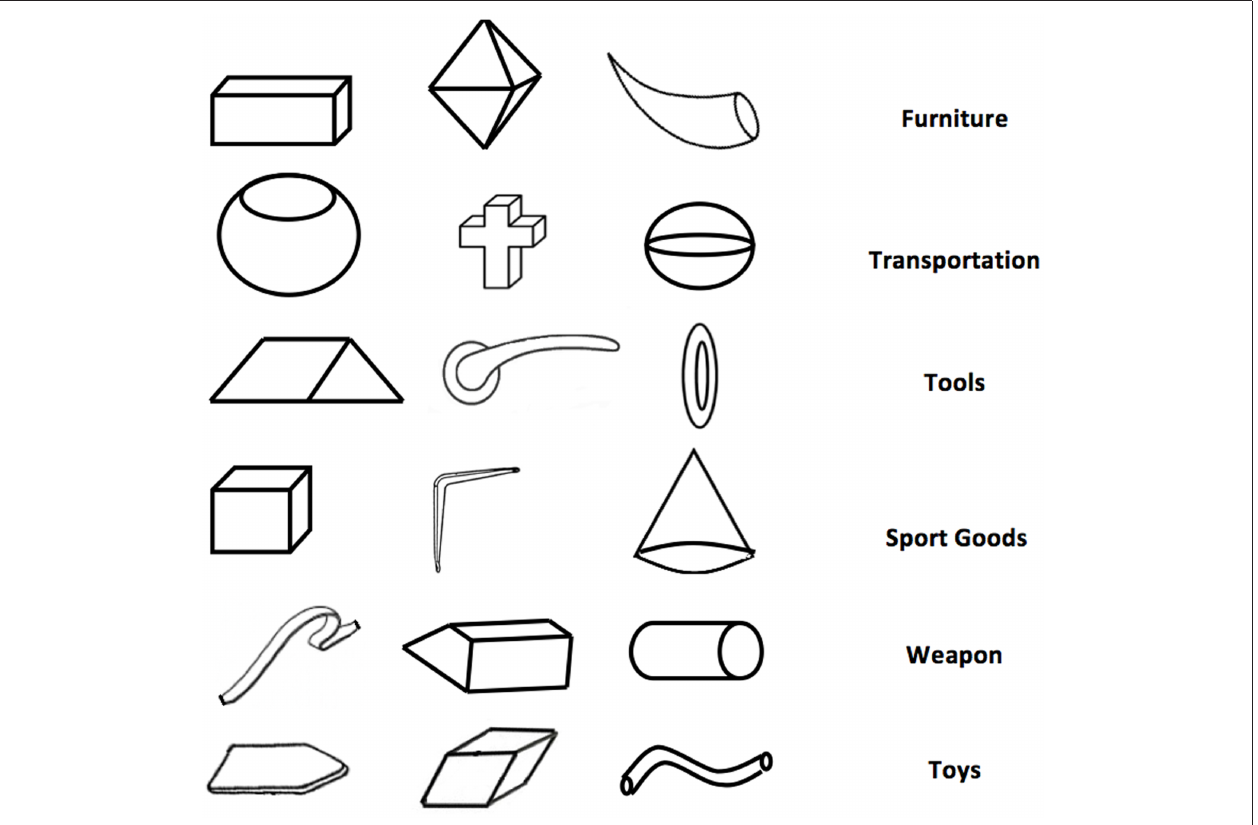
FIGURE 1 | Triads of Elements for the Figural Combination Task: (1) rectangular block, dipyramid, horn (furniture); (2) pot, cross, sphere (transportation); (3) rhombus, handle, ring (tools); (4) cube, bracket, cone (sport goods); (5) strip, trapezoid, cylinder (weapons); (6) board, rhomboid, tube